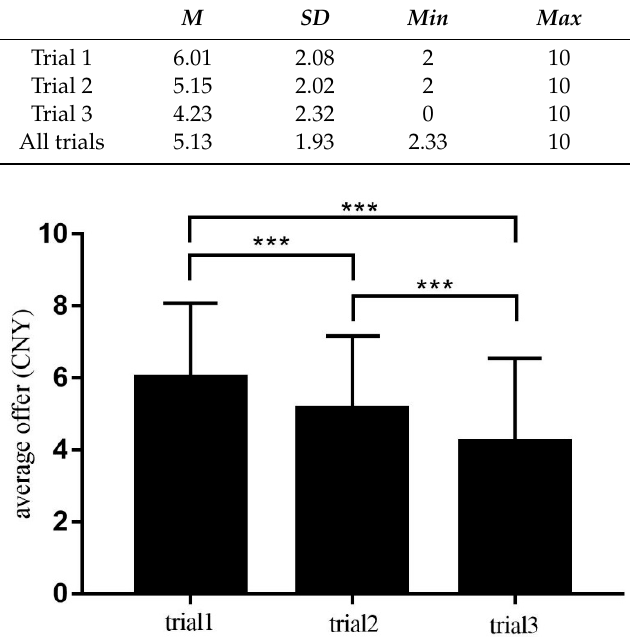
Table 1. The results of the descriptive statistical analysis of dictators’ giving.